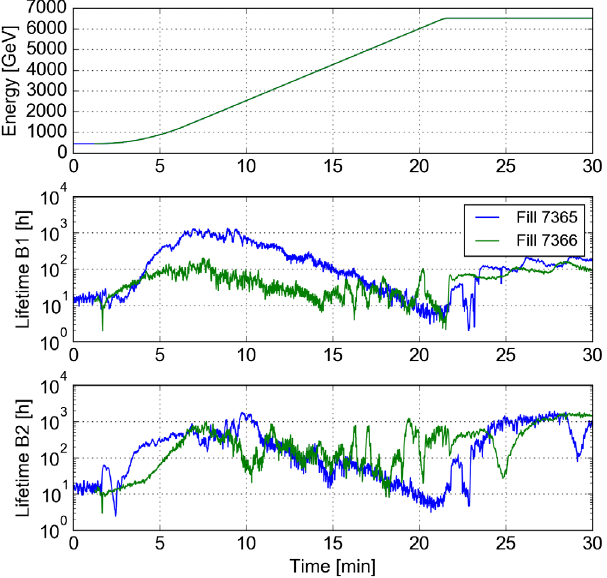
FIG. 9. 2018 ATS MD: beam lifetime with 8b4e trains ( ∼ 1 . 6 × 10 11 p = b wit γϵ ∼ 3 μ m) for the CRDS (Fill 7365 with 800 bunches) and the nominal CRS (Fill 7366 with 1600 bunches). Courtesy of G. Iadarola